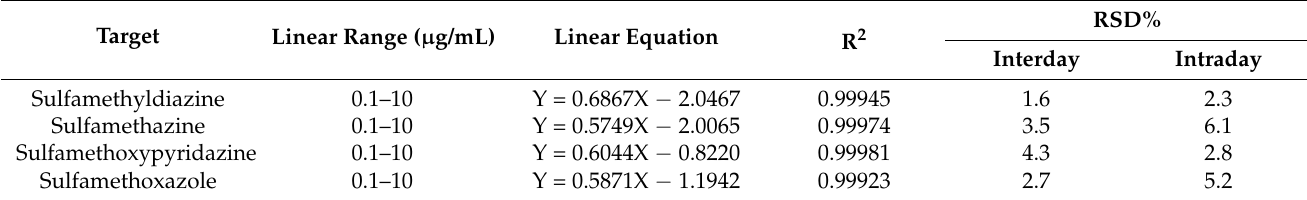
Table 2. Linear equation, detection limit, and relative standard deviation of the four sulfonamides (n =